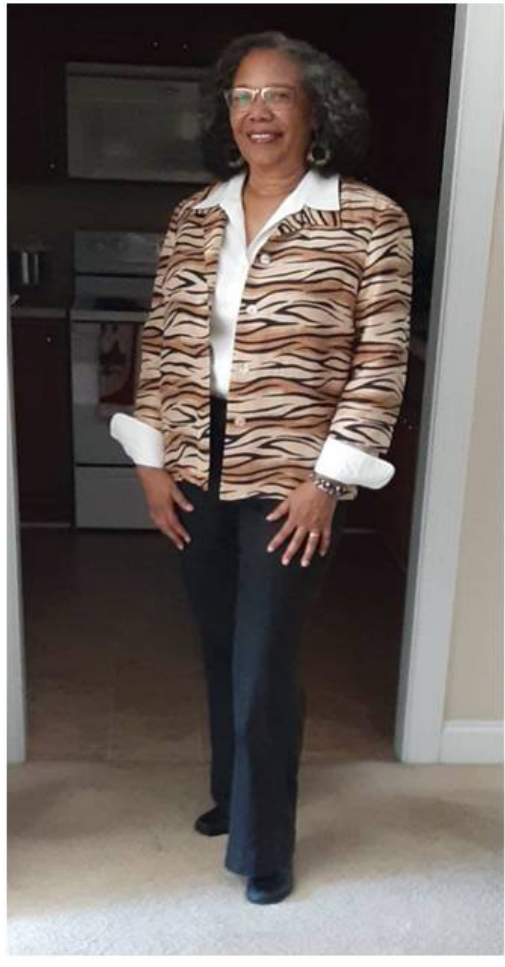
Figure 5. Portrait of Hancock county resident, storyteller and community organizer Jeanette Waddell in Sparta, Georgia. Waddell was instrumental in the restoration the downtown Sparta mural of Bishops Holsey and Pierce and co-organized the wedding re-enactment at Sunshine as part of the Fall Line Festival in Sparta, Georgia in late 2019. Photograph courtesy of Jeanette Waddell.